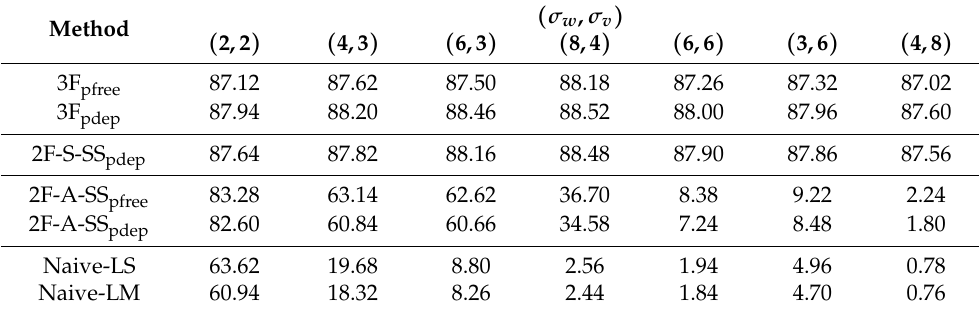
Table 1. True model selection rate (%): BIC.